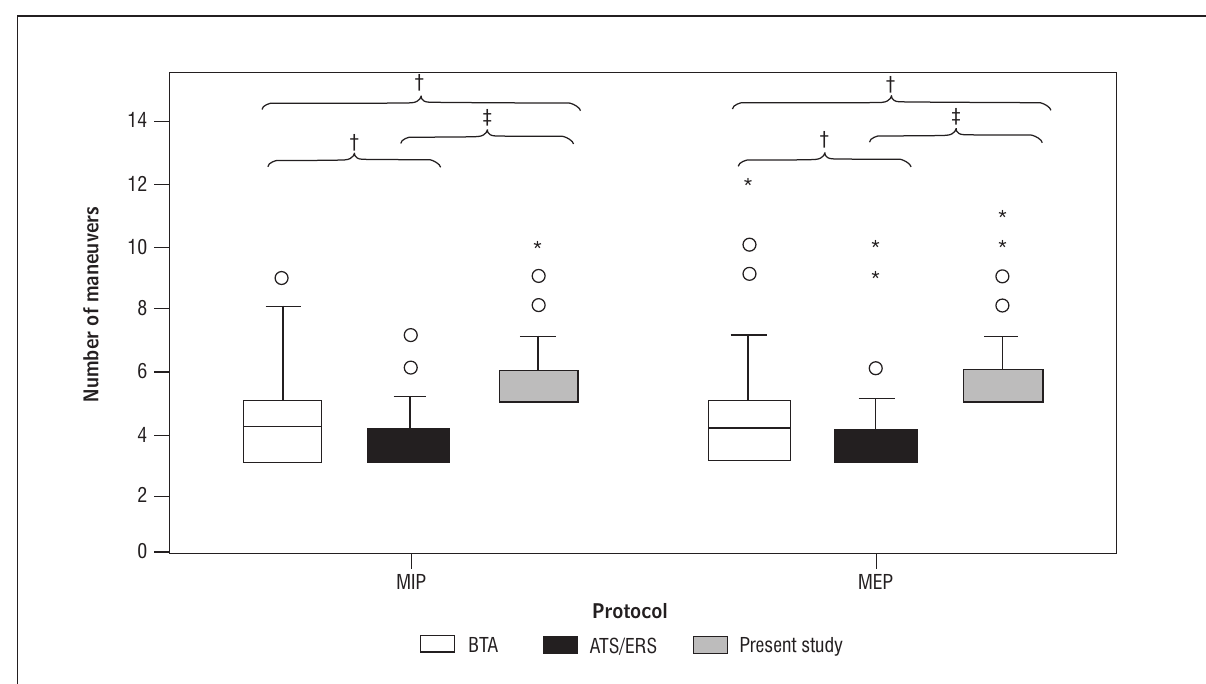
Figure 1 - Number of maneuvers required to achieve the reproducibility criteria proposed by the Brazilian Thoracic Association (BTA), by the American Thoracic Society/European Respiratory Society (ATS/ERS) and by the present study Note: MIP refers to maximal inspiratory pressure and MEP refers to maximal expiratory pressure. ˚ Outlier. * Extreme. Friedman test with Wilcoxon post hoc. † Different from SBPT. ‡ Different from ATS/ERS .